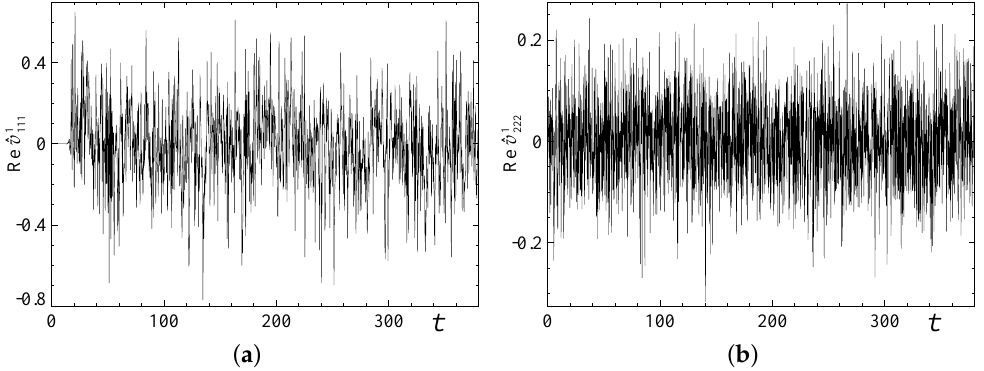
Figure 26. Temporal behaviour of the Fourier coefficients Re ˆ v 1